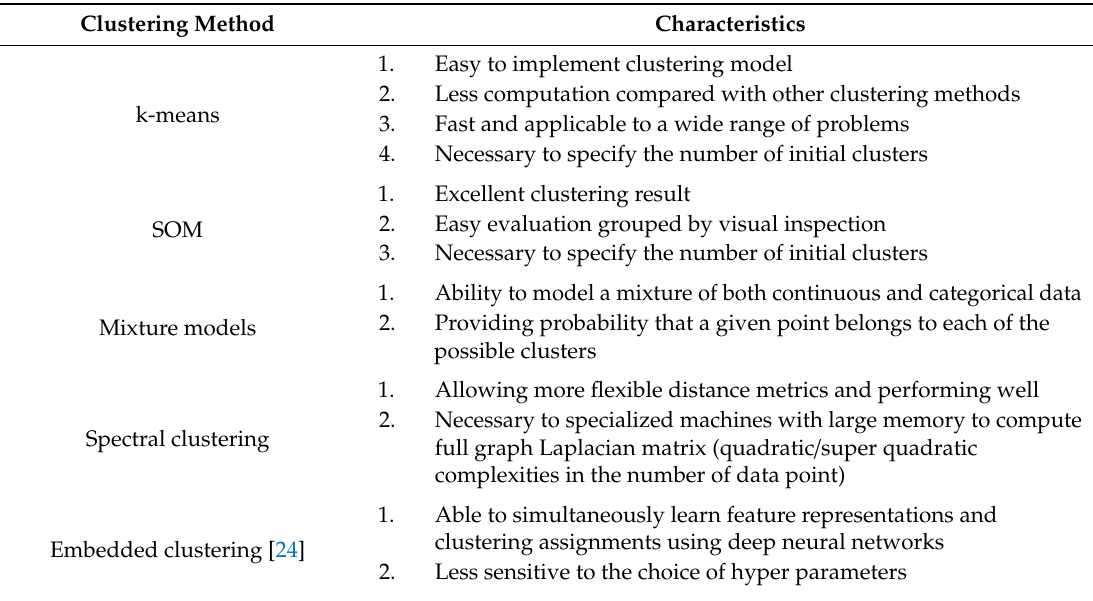
Table 1. Characteristics of previous clustering